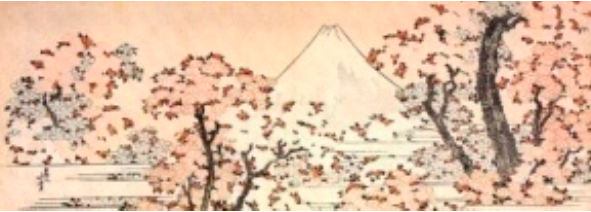
Figure 4. Katsushika Hokusai (1760–1849). Mount Fuji seen through the cherry blossoms (1834), https://